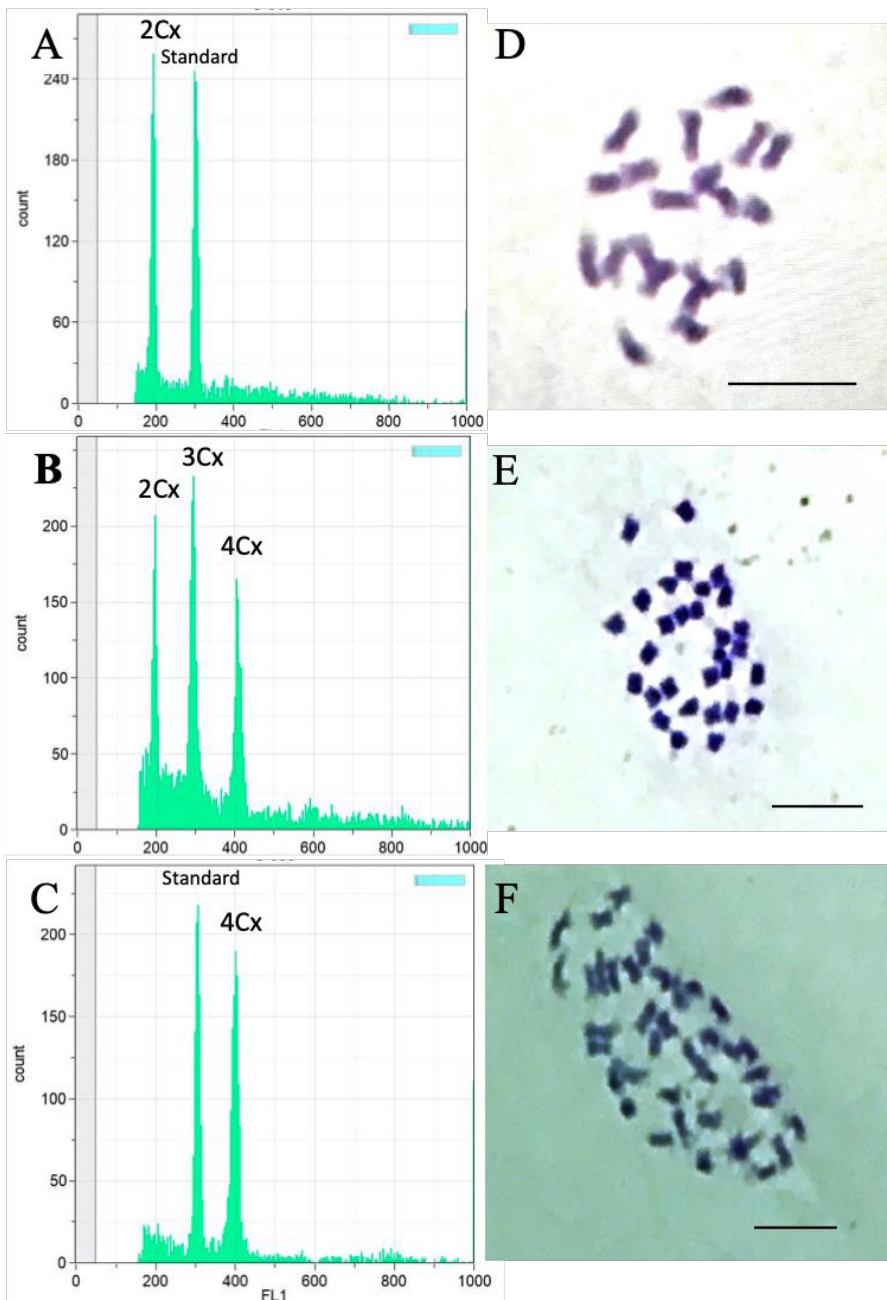
Figure 2. Ploidy identification by flow cytometry and chromosome squashes. Flow cytometric analysis of ( A ) a diploid C. sativa ‘Stem Cell CBG’ shown with the internal standard, ( B ) diploid, triploid, and tetraploid F 1 hybrids, and ( C ) a tetraploid F 1 hybrid and internal standard. Chromosome squash of ( D ) a diploid C. sativa ‘Stem Cell CBG’ (2n = 2 x = 20), ( E ) a triploid ‘Stem Cell CBG Seedless’ (2n = 3 x = 30), and ( F ) a tetraploid F 1 hybrid (2n = 4 x = 40). Internal standard (standard) = QA reference beads UV bright 3 μm (Quantum Analysis GmbH, Münster, Germany). Bar = 10 μm.